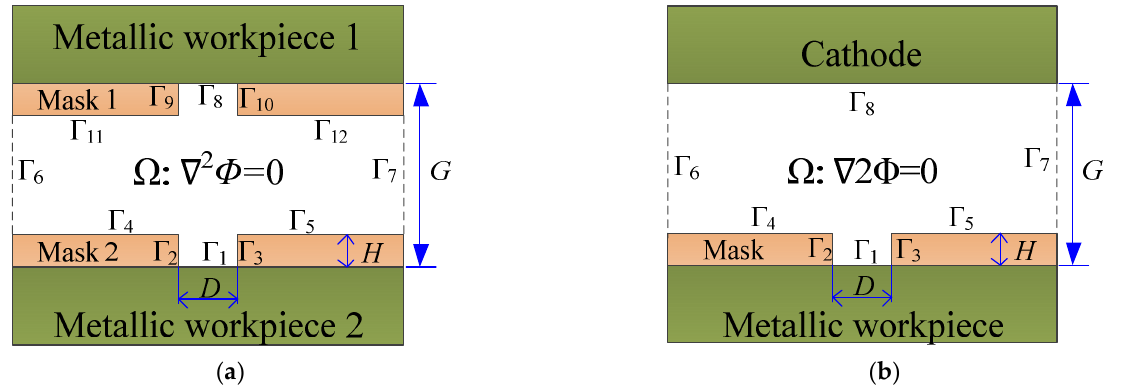
Figure 2. The model for the simulation. ( a ) bidirectional pulse; ( b ) unidirectional pulse.